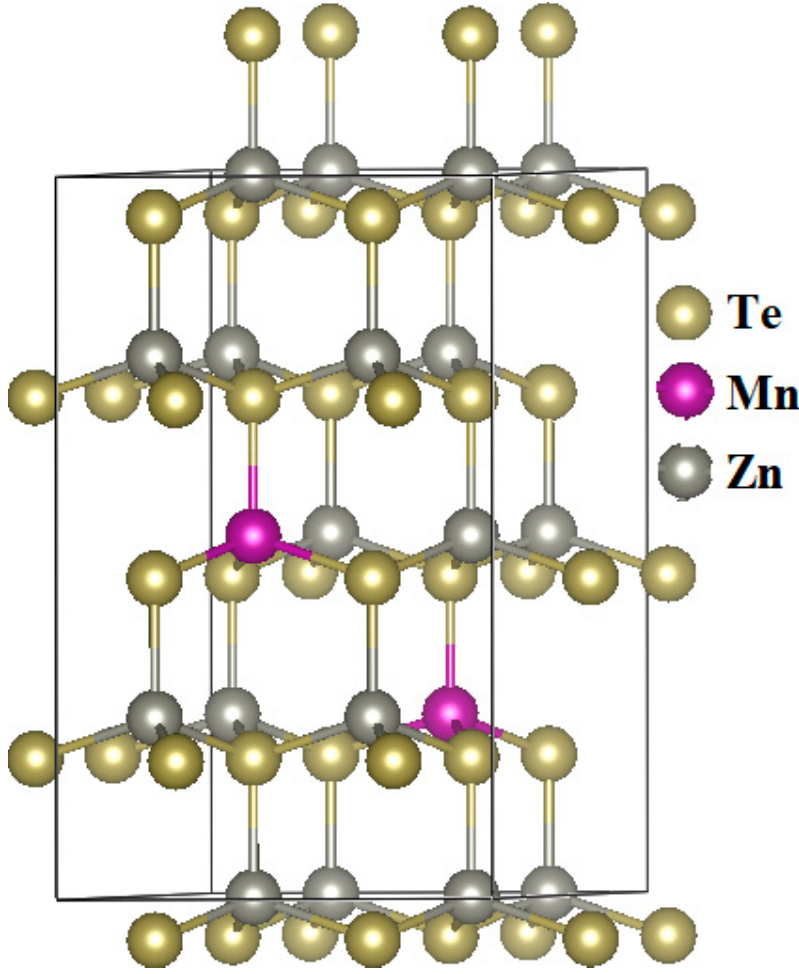
Figure 1. Representation and labeling of unit cell structure for Mn x Zn 1 − x Te (x = 8% and 16%) crystalline solid state alloys.